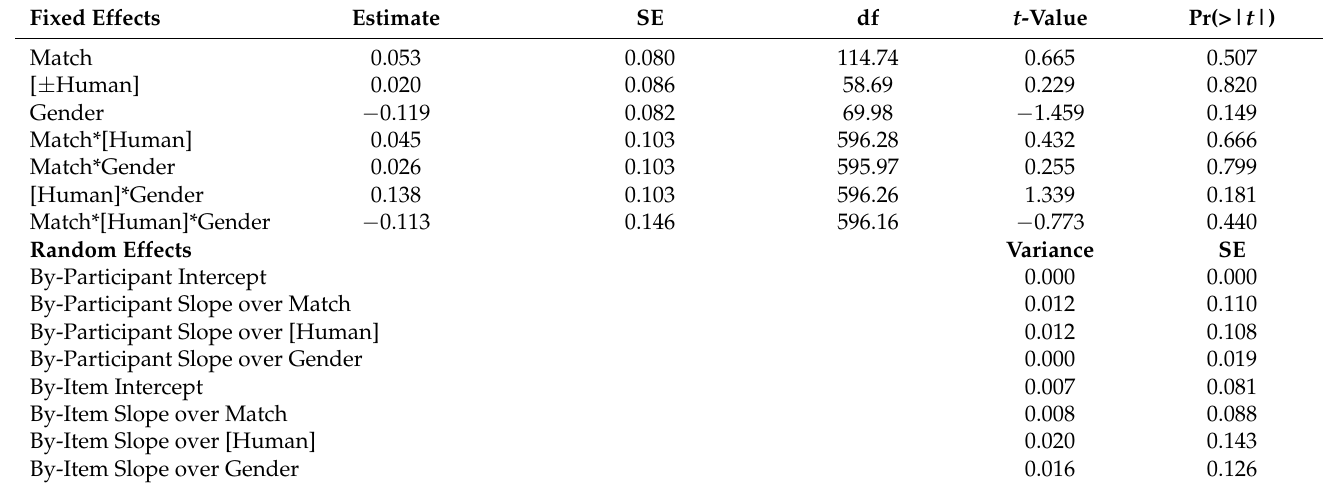
Table A1. Linear mixed-effects model, postverbal region (Region 5-SPR), L2 group.